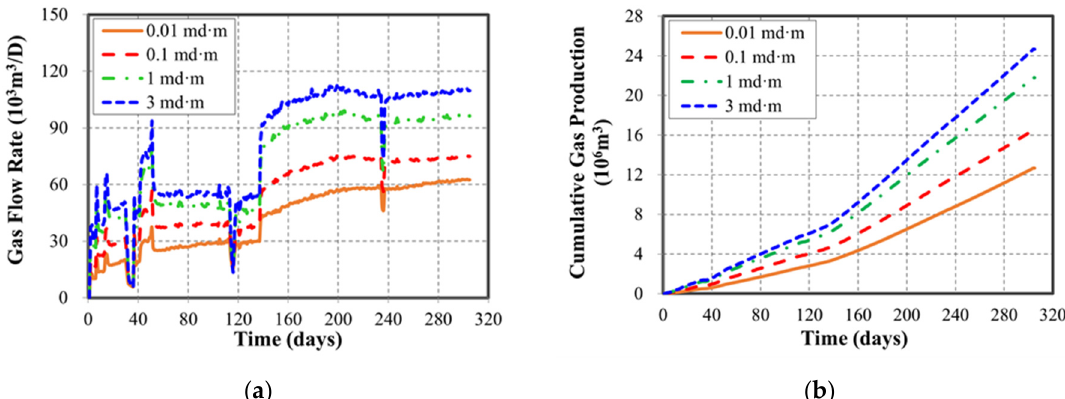
Figure 9. Production with different natural fracture conductivity values: ( a ) gas flow rate; ( b ) cumu- lative gas production.